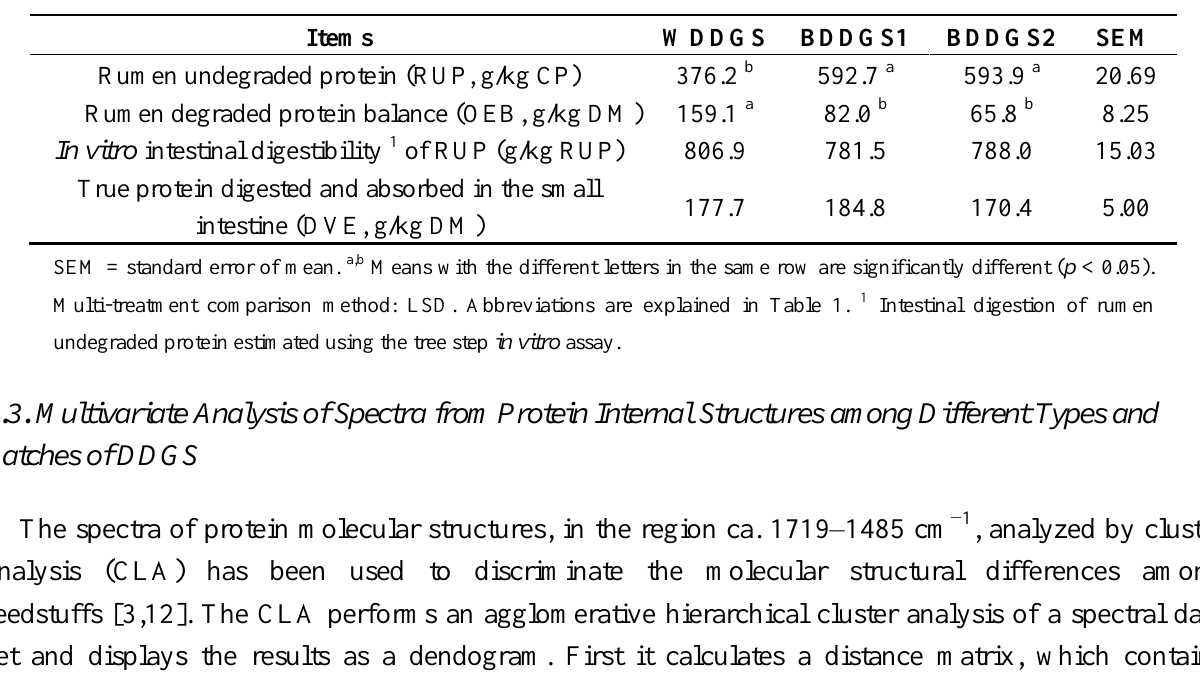
Table 5. Rumen undegraded protein, protein digestibility and digested rumen undegraded protein in wheat and blend